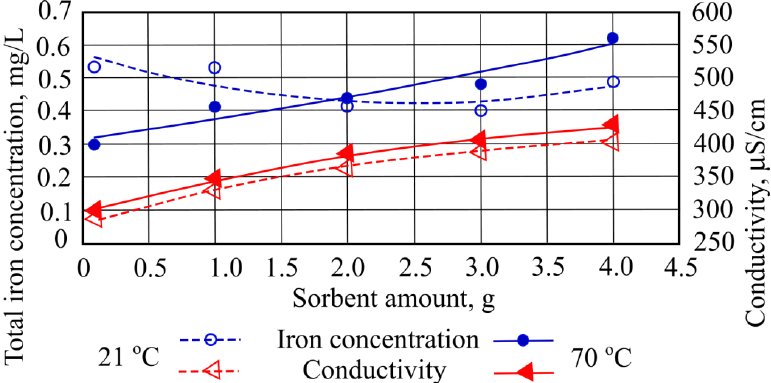
Figure 1. Total iron concentration and conductivity when different quantities of straw sorbent are added to the wastewater.